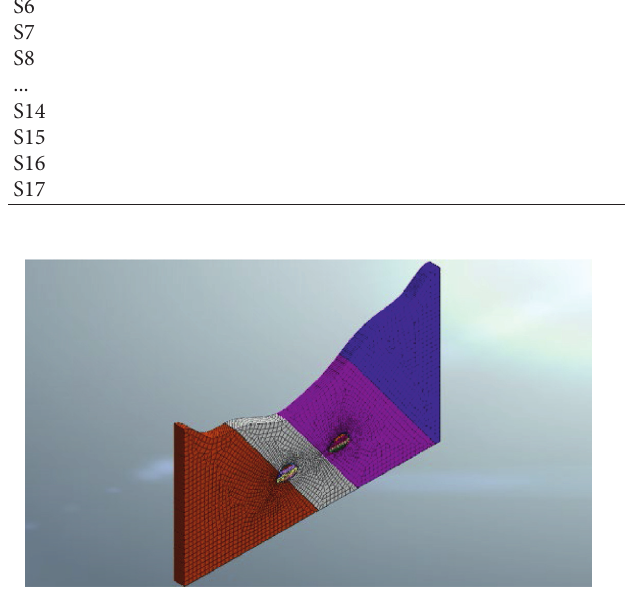
Figure 8: Model of the three-step method.